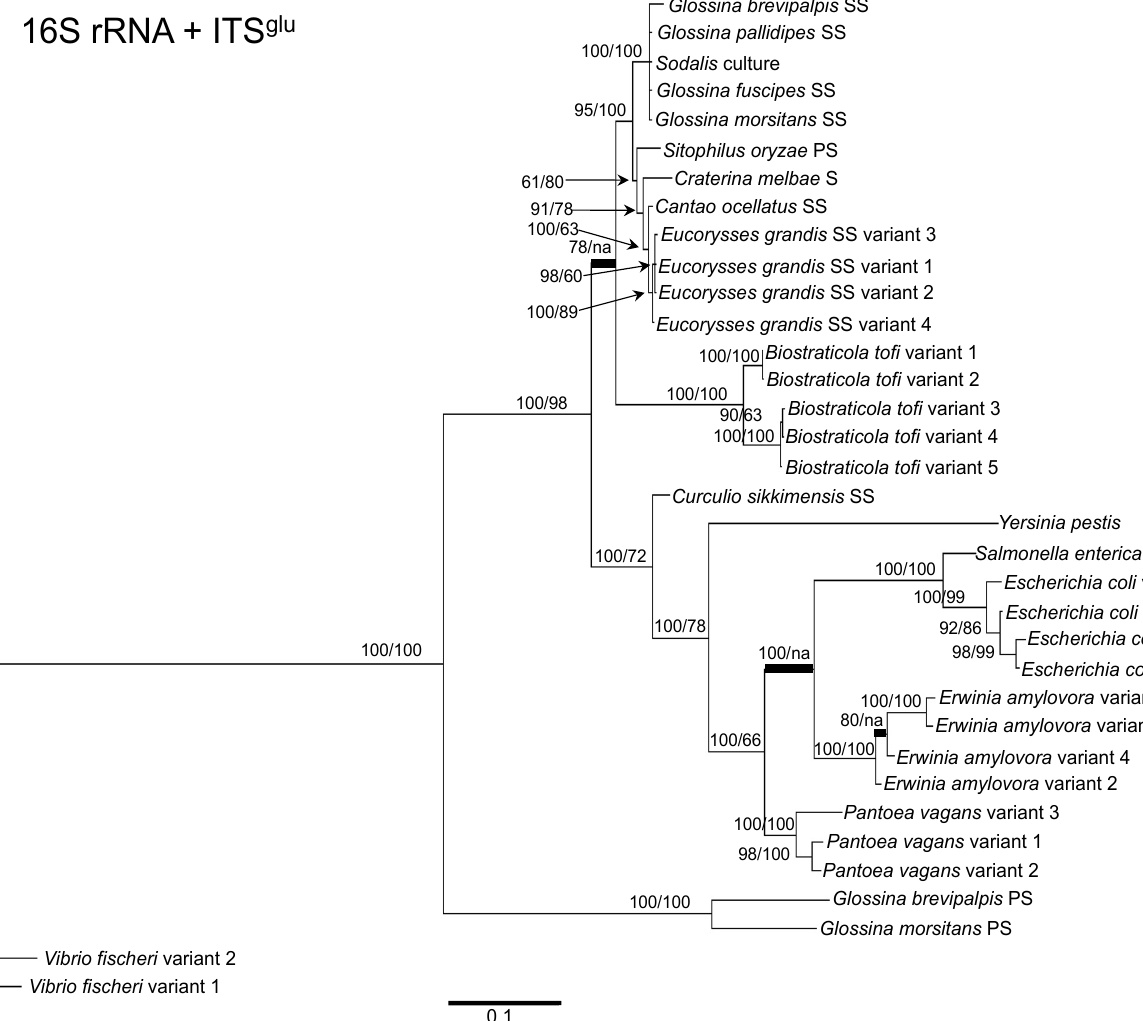
Figure 1. Phylogenetic placement of Sodalis and related symbiotic bacteria within Gammaproteobacteria based on 16S rRNA and ITS glu concatenation. A Bayesian tree, inferred from a total of 2,467 unambiguously aligned nucleotide sites, with support values indicating Bayesian posterior probabilities (PP)/MP bootstrap (BS) is shown. PP indicated as percentage, i.e ., PP = 0.95 is depicted as 95. Branches constrained with MP are shown in bold. For insect symbionts, host species are indicated. S = symbiont, SS = S-symbiont, PS = P-symbiont. Scale bar represents